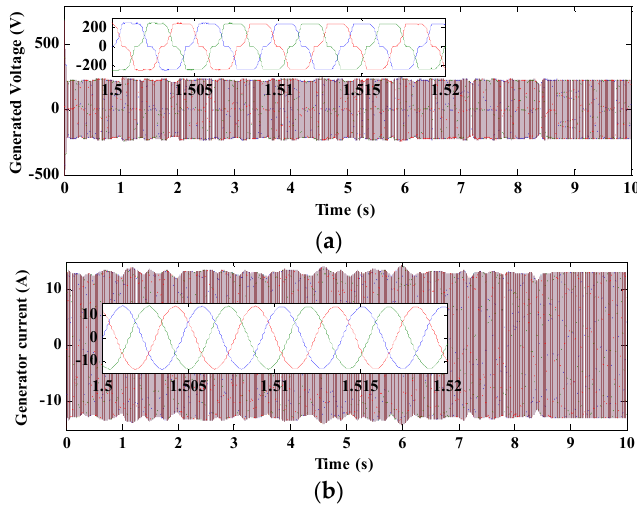
Figure 12. Generated output parameters of permanent magnet synchronous generator (PMSG), ( a ) voltage; ( b ) current.